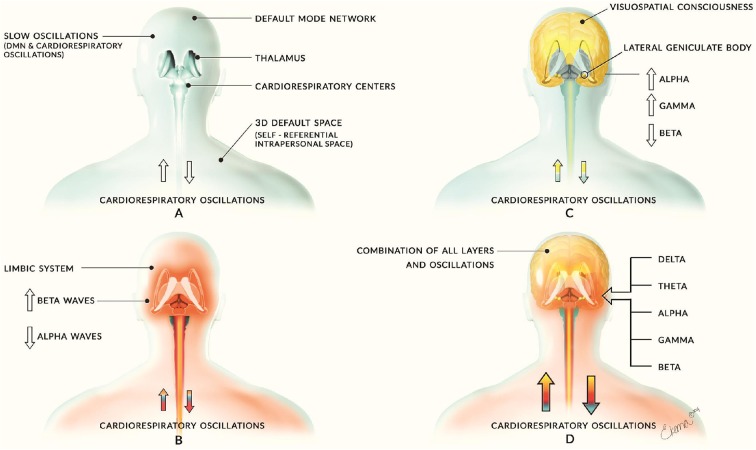
Introductory model of layered activity. This image comes from our initial article on this theory of which we have significantly improved in the updated version. Panel (A) illustrates the base layer of slow neural oscillations of the Default Mode Network (DMN) and cardiorespiratory activity. This creates a foundation for all other layers of oscillatory activity and is depicted by the blue coloring. Panel (B) shows the second layer of middle-frequency activity largely consisting of limbic activity and is depicted by red coloring. Panel (C) reveals the corticothalamic feedback loops involved in cognitive and consciousness processes and is illustrated with yellow coloring. Panel (D) combines these layers to form the sum of human neural activity consisting of all neural and physiological oscillations. The multi-colored arrows of each person represent the layers interacting with the cardiorespiratory system with the appropriate color for each layer. Previously published in Jerath and Crawford (2015), permission by CC-BY.